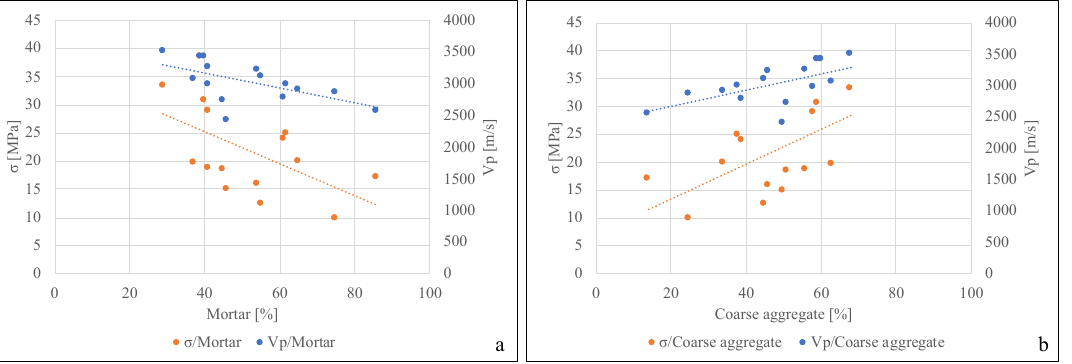
Figure 9. Diagram of correlation between σ, Vp, and % of fine portion of core samples ( a ); σ, Vp, and % of coarse aggregate ( b ).